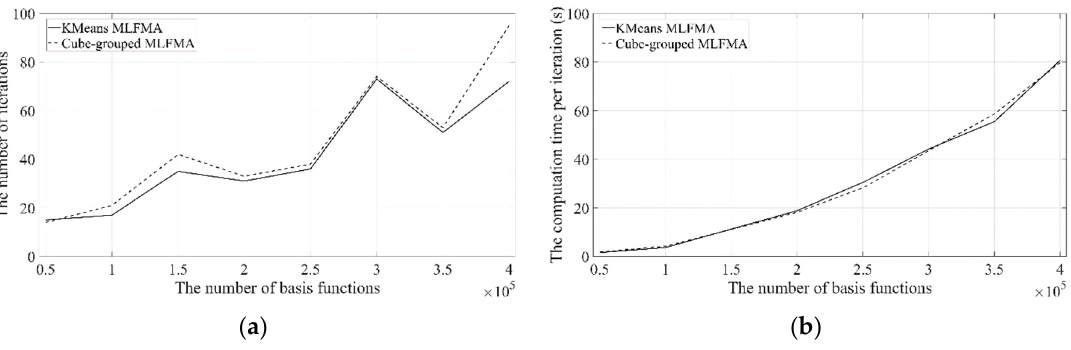
Figure 9. Canonical sphere CAD model simulation results: ( a ) the number of iterations as a function of the number of basis functions; ( b ) the computation time per iteration as a function of the number of basis functions.